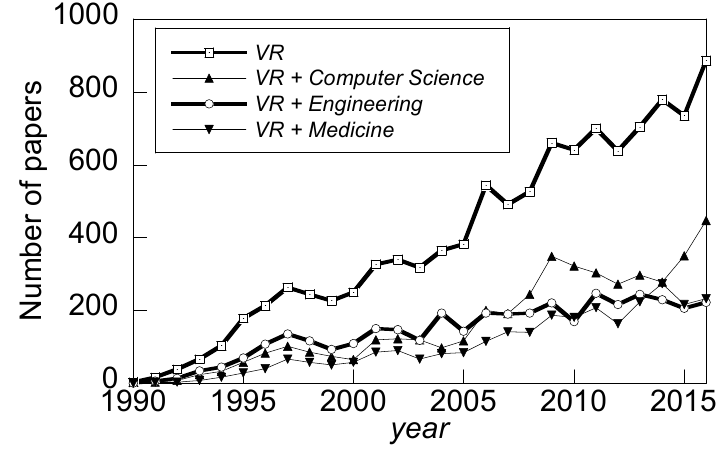
Figure 1. The number of research papers indexed in SCOPUS related with the following keywords in the title: (i) Virtual Reality; (ii) Virtual Reality and Computer Science; (iii) Virtual Reality and Engineering; and (iv) Virtual Reality and Medicine. (Data collected on February 2017).